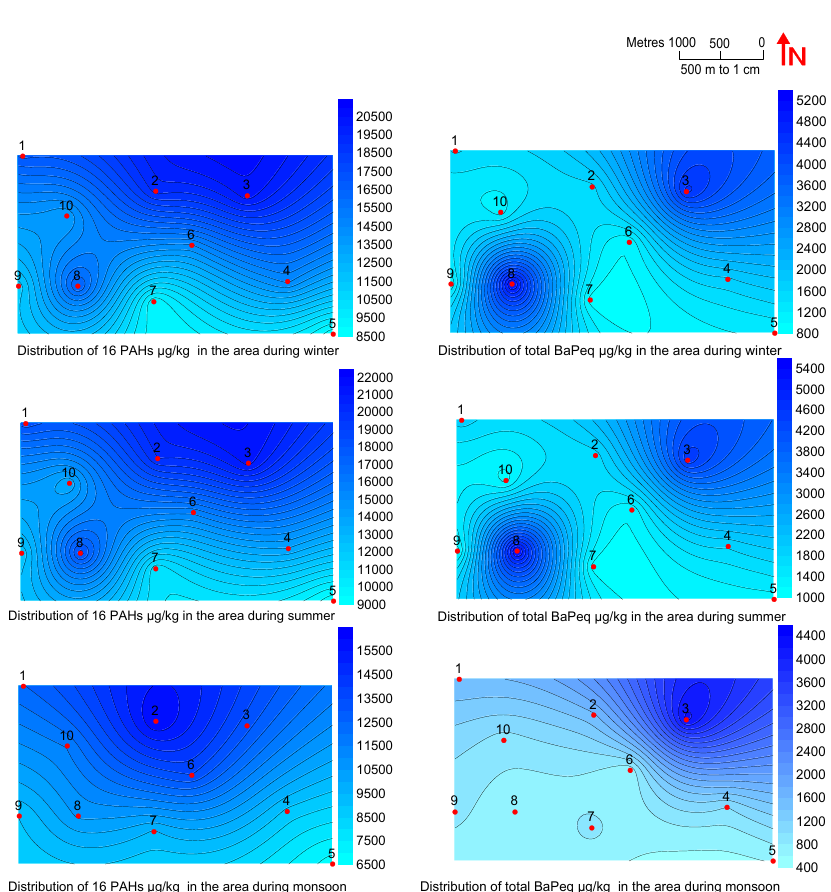
Fig. 5: Spatial distributions of Σ 16 PAH and BaPeq in soil